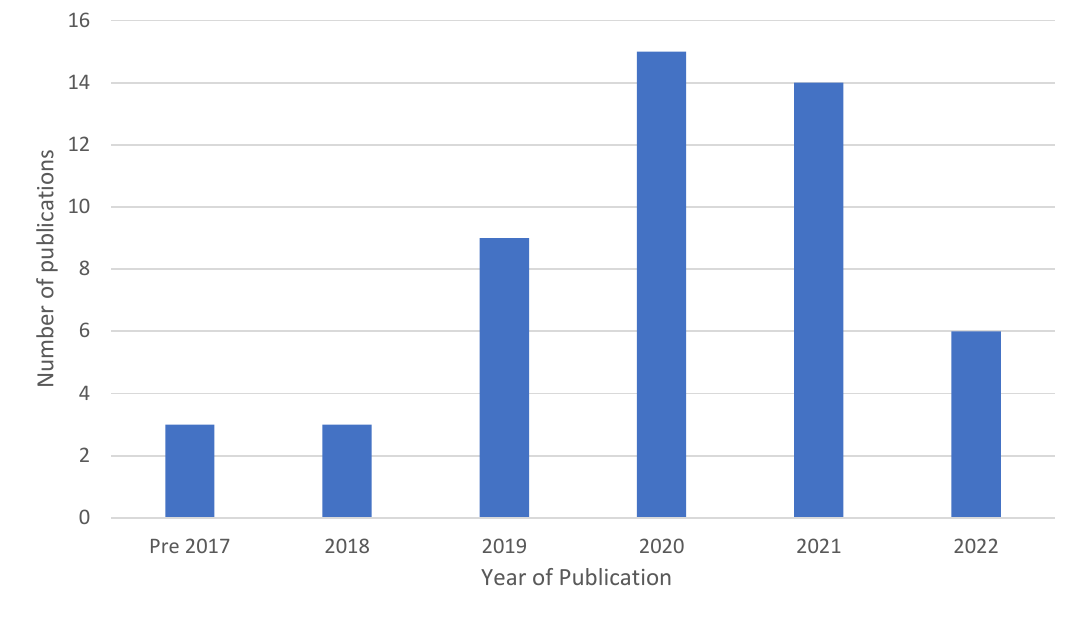
Figure 4. Publication of research.